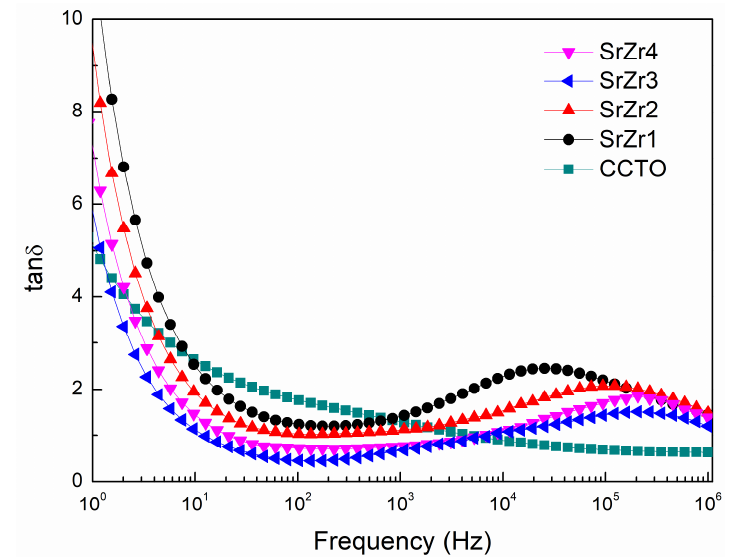
Figure 6. Frequency dependence of the dielectric loss (tanδ) obtained for the CCTO, SrZr1, SrZr2, SrZr3, and SrZr4